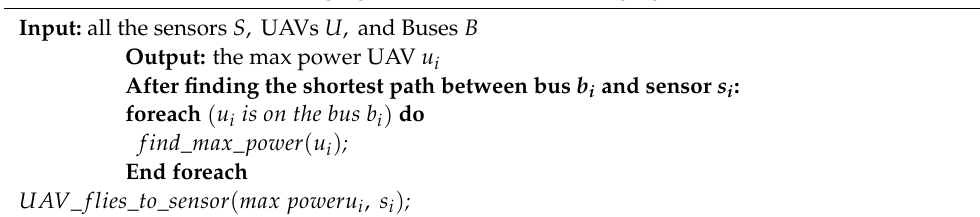
Algorithm 3: Max Power Charging (with Shortest Path